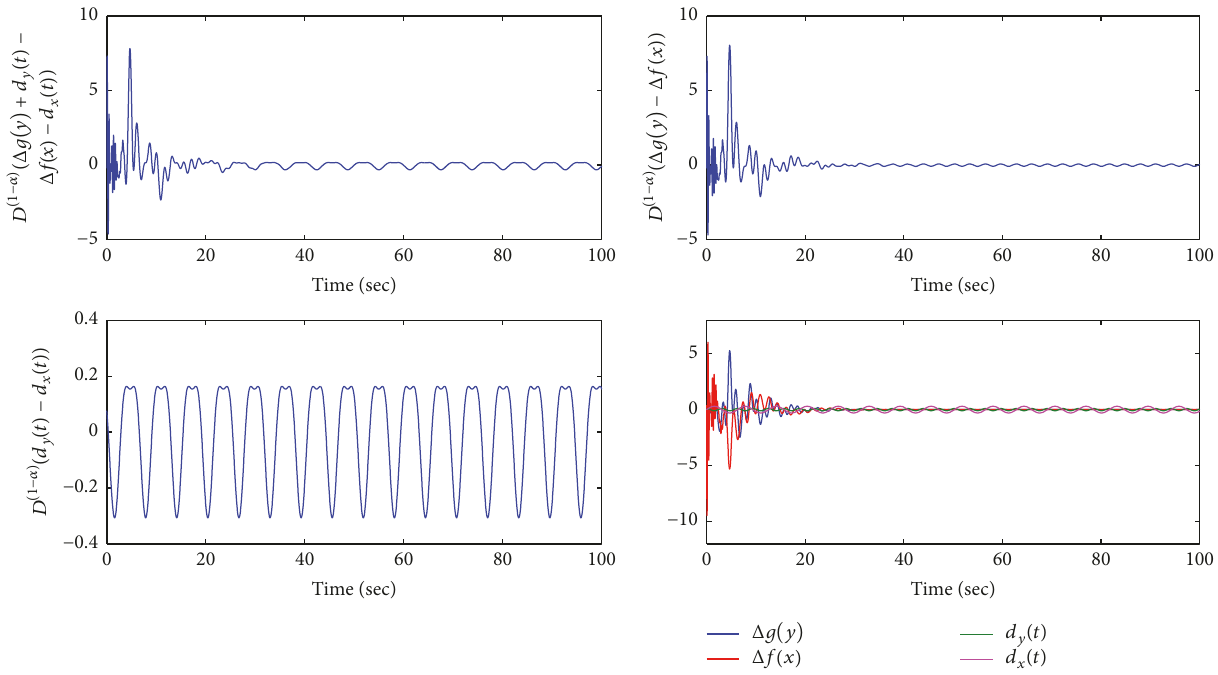
Figure 1: The simulation results for the boundedness of the given uncertain parameter and external disturbance.